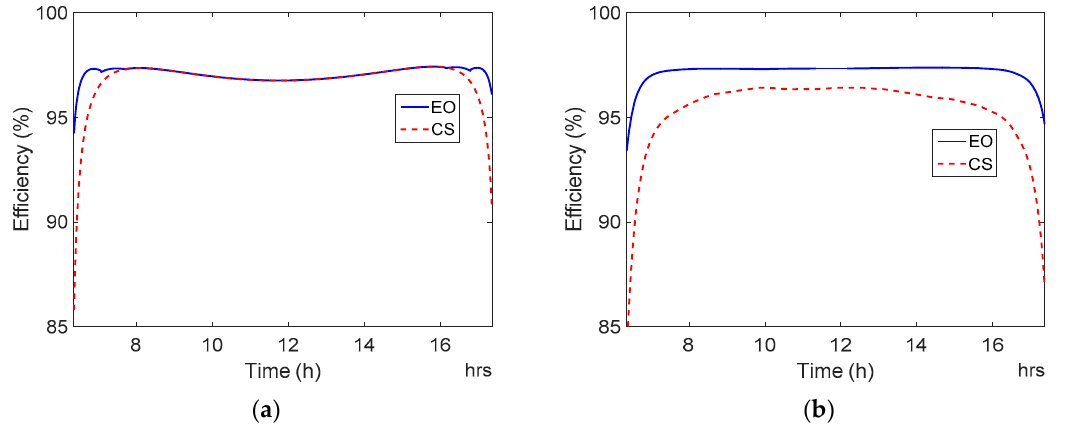
Figure 19. Daily e ffi ciency curves of Power Electronics FS0900CU with average current-sharing control Figure 19. Daily efficiency curves of Power Electronics FS0900CU with average current-sharing method ( CS ) and e ffi ciency-oriented method ( EO ). ( a ) Sunny day. ( b ) Cloudy control method ( CS ) and efficiency-oriented method ( EO ). ( a ) Sunny day. ( b ) Cloudy day.